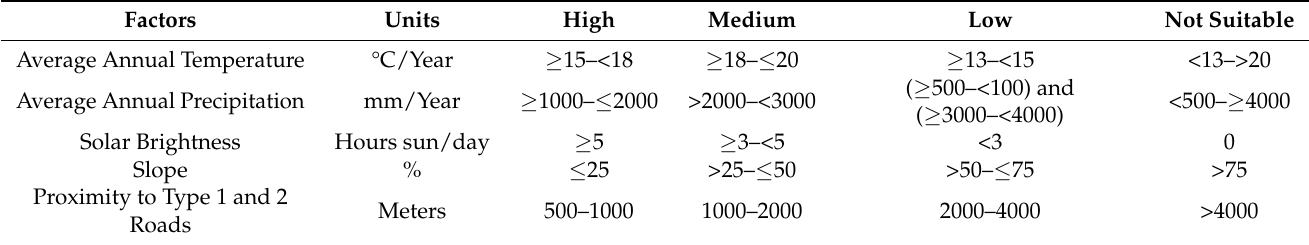
Table 2. Suitability ranges defined for each of the criteria in the